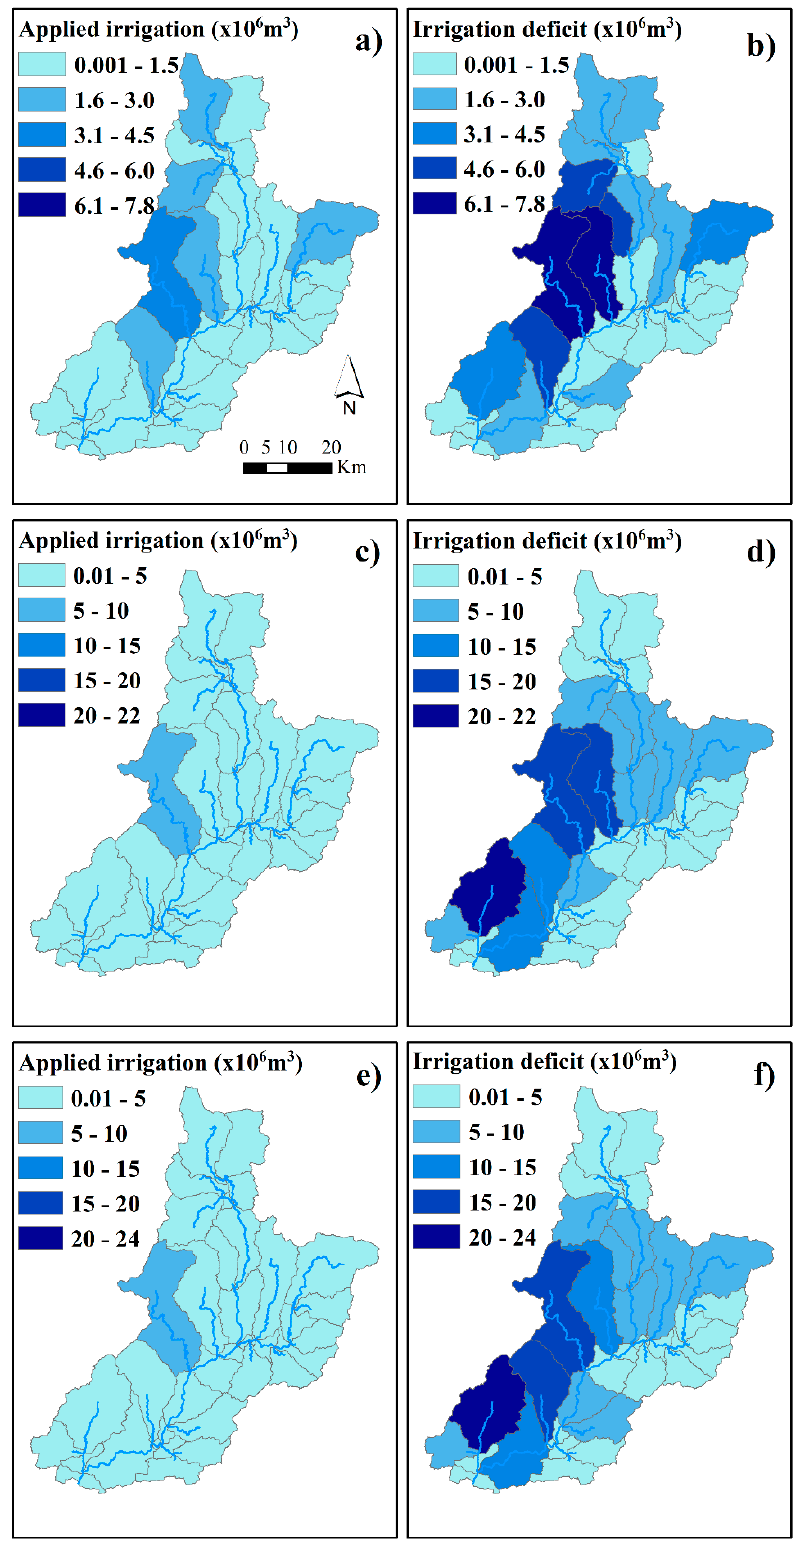
Figure 8. The applied irrigation and irrigation deficit at sub-basin scale in the Sabor River basin. ( a ) and ( b ) represent the applied irrigation and the irrigation deficit in the historical view, respectively. Figures ( c ) and ( d ) represent the data on the scenario of an increase in the irrigated area, and ( e ) and ( f ) represent the data on the scenario of a projection to 2060.